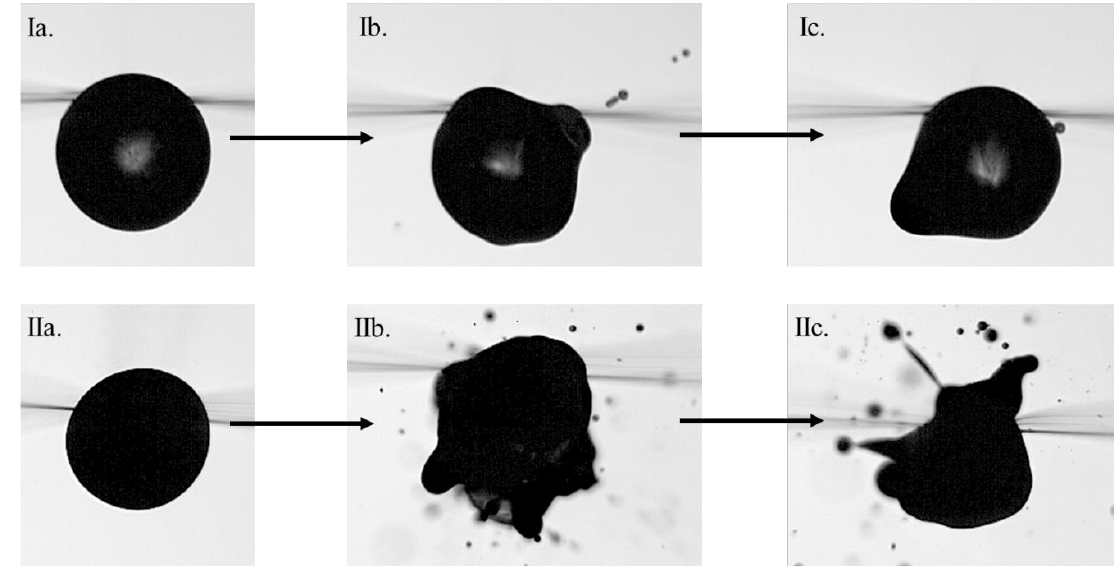
Figure 2. High-speed camera images showing distortion and microexplosions in Colorado (Ia, Ib, Ic) and Texas (IIa, IIb, IIc) crudes.